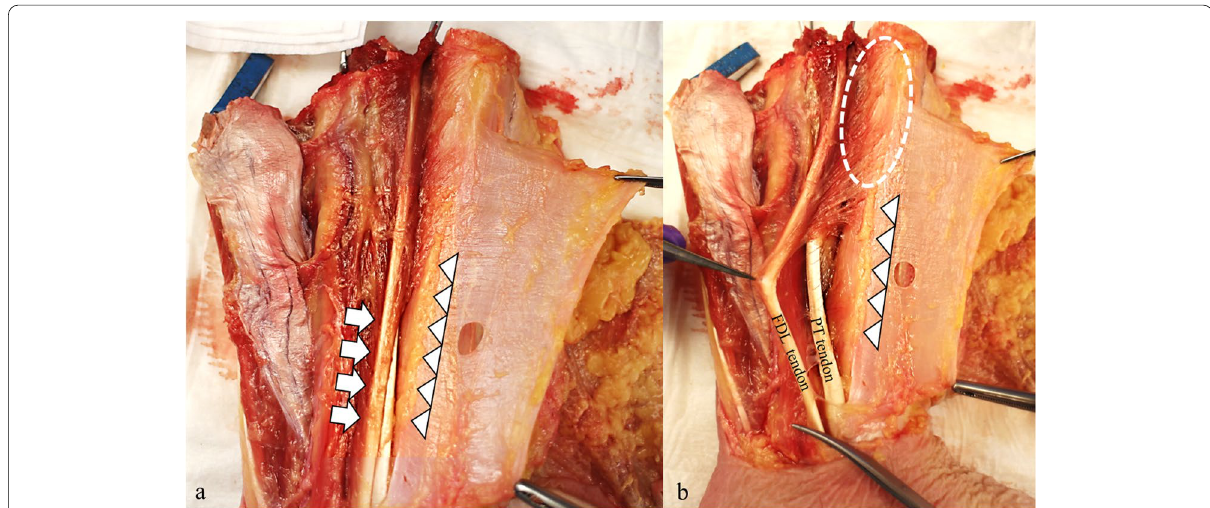
Fig. 7 The crural fascia is excised and opened on the left lower leg. The adipose tissue (yellow soft tissue) is confirmed along the posteromedial tibial border (white arrowhead). a : The adipose tissue is present in front of the flexor digitorum longus (FDL) muscle–tendon and posterior tibialis muscle (PT) tendon (white arrow). b : Pulled FDL origin (white dashed line circle) seen at the more proximal adipose